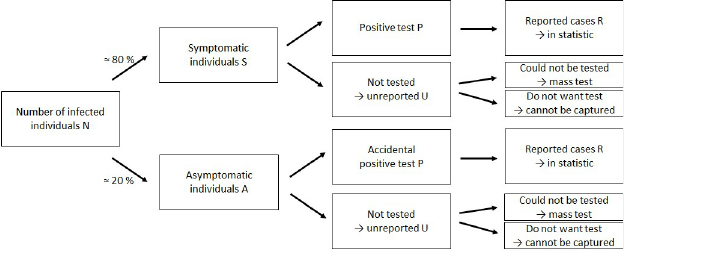
Fig 1. Composition of true number of